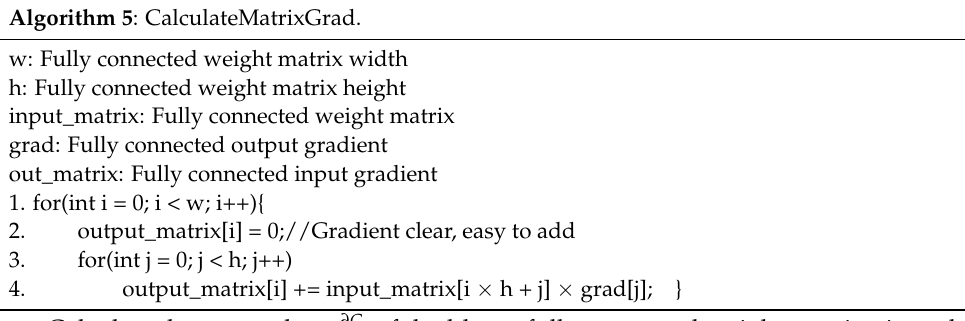
Algorithm 5 : CalculateMatrixGrad.